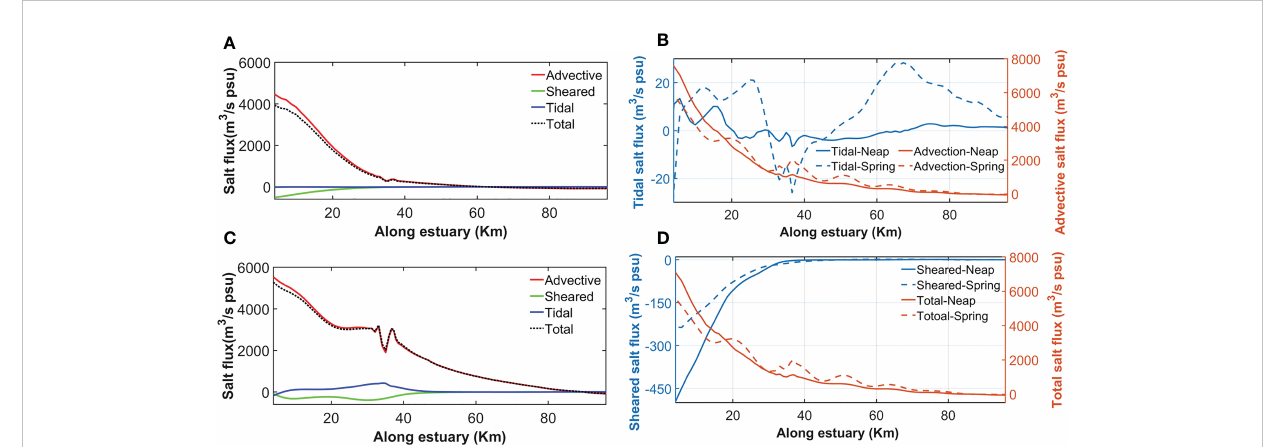
FIGURE 11 The distribution of the time averaged different salt fl ux terms along the estuary from the micro-tidal EXP5 (A) and from the meso-tidal EXP10 (C) , (see Table 1). Comparing the time averaged (75 hours) neap-spring salt fl uxes from the tidal and advective terms (B) and from the sheared and total salt fl uxes (D) in EXP3. The total salt fl ux equals advective plus sheared and tidal pumping. Positive fl uxes are